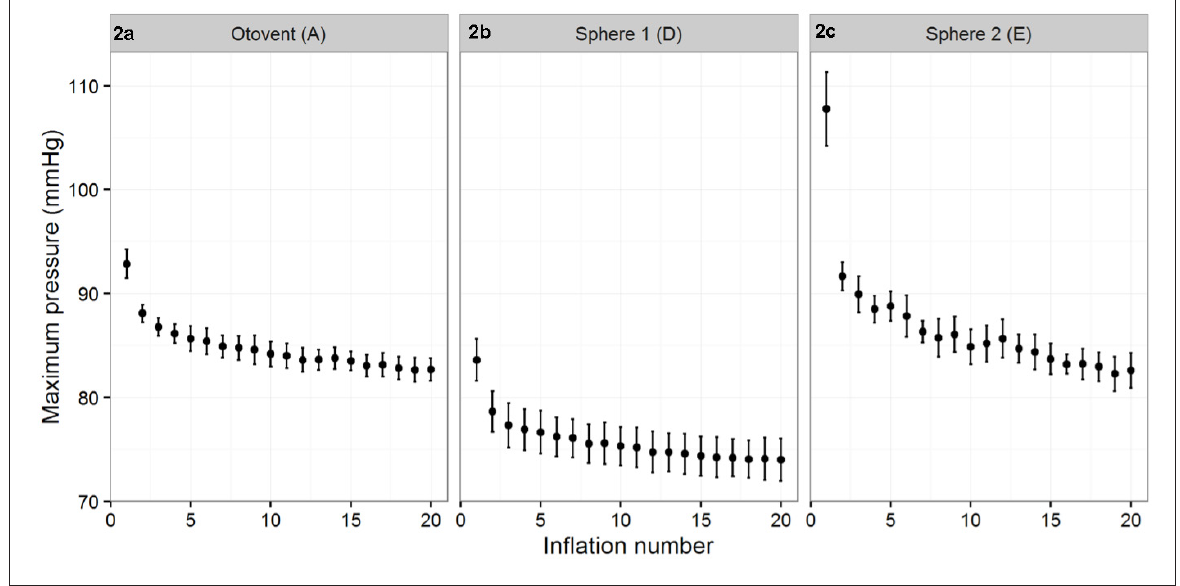
Figure 2 Mean inflation pressures (2–20) and standard deviation of (Figure 2a) Otovent (A), n = 8; (Figure 2b) sphere 1 (D), n = 10; (Figure 2c) sphere 2 (E), n =